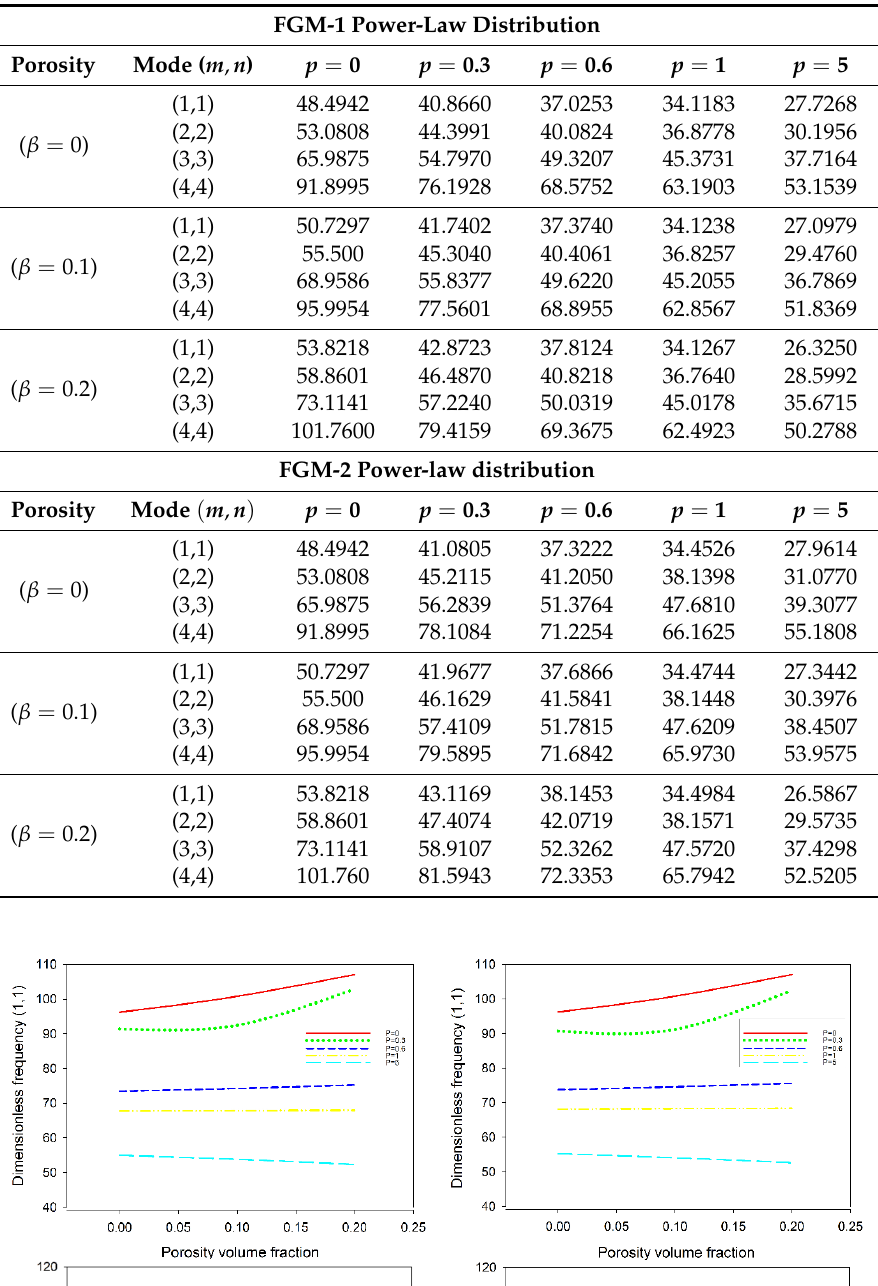
Table 5. Dimensionless frequency of simply-supported (SSSS) functionally graded porous circular cylindrical shell as functions of the power-law index and porosity volume fraction.